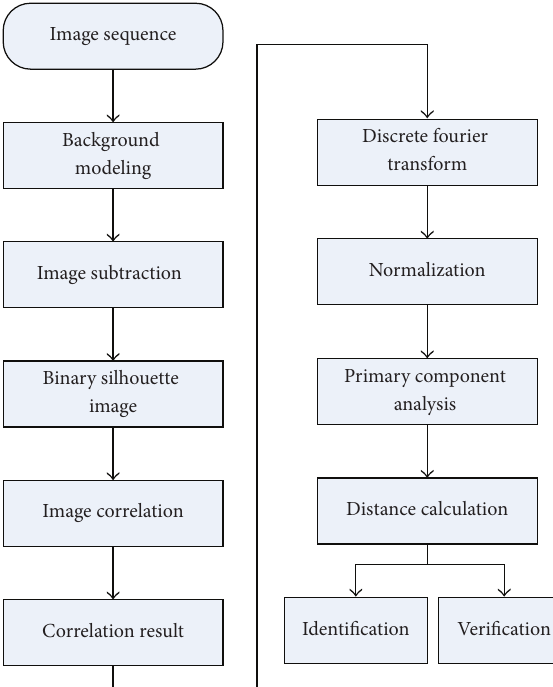
Figure 1: Overview of our human identification method.